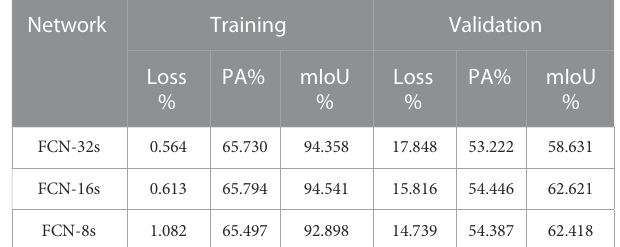
TABLE 1 The accuracy evaluation indicators of the training and validation datasets.